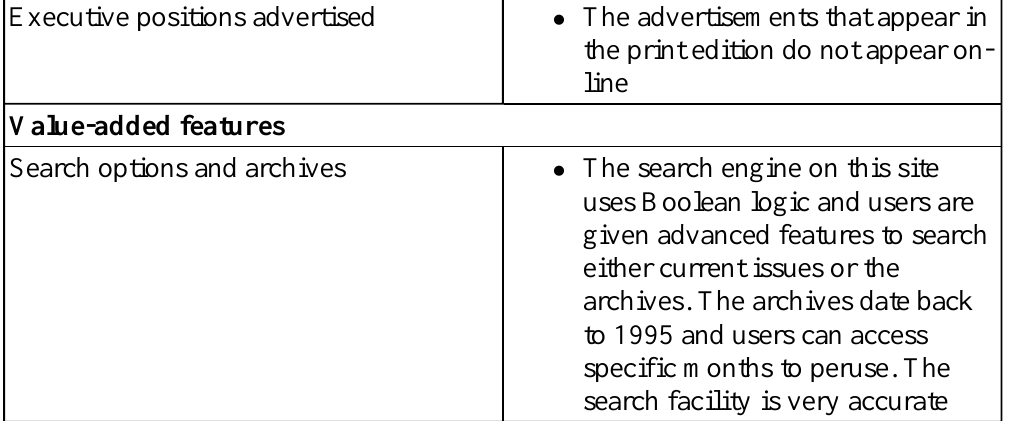
Table 9 Summary of the compliance of the Sunday Times Business Times on-line to three evaluation criteria